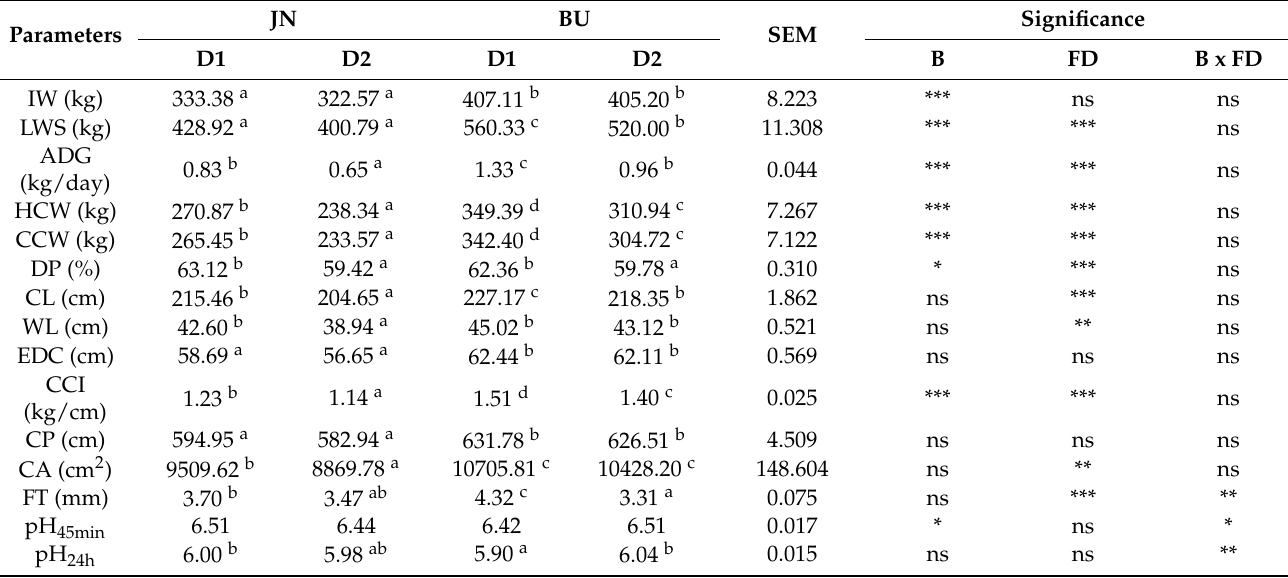
Table 2. Effect of breed and finishing diet on productive variables, carcass measurements, and carcass pH values from Jaca Navarra (JN) and Burguete (BU)